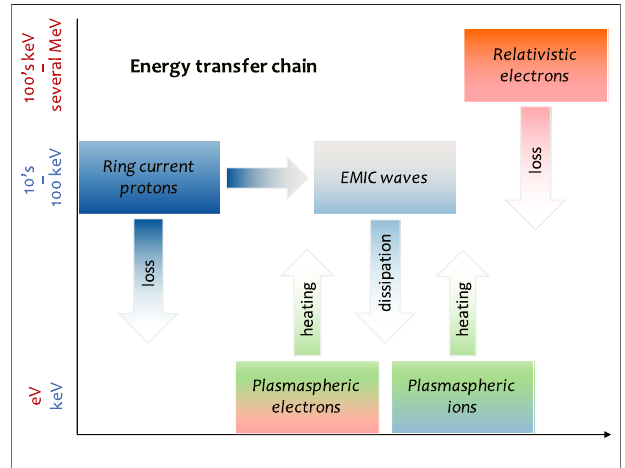
FIGURE 1 | Energy exchange between magnetospheric plasma populations via the intermediacy of EMIC